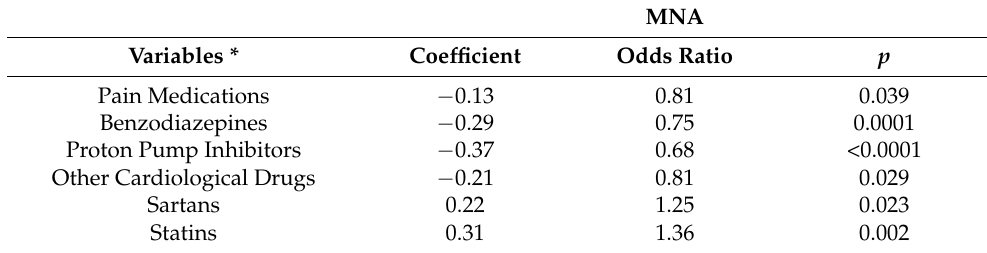
Table 5. Logistic Regression MNA vs. classes of